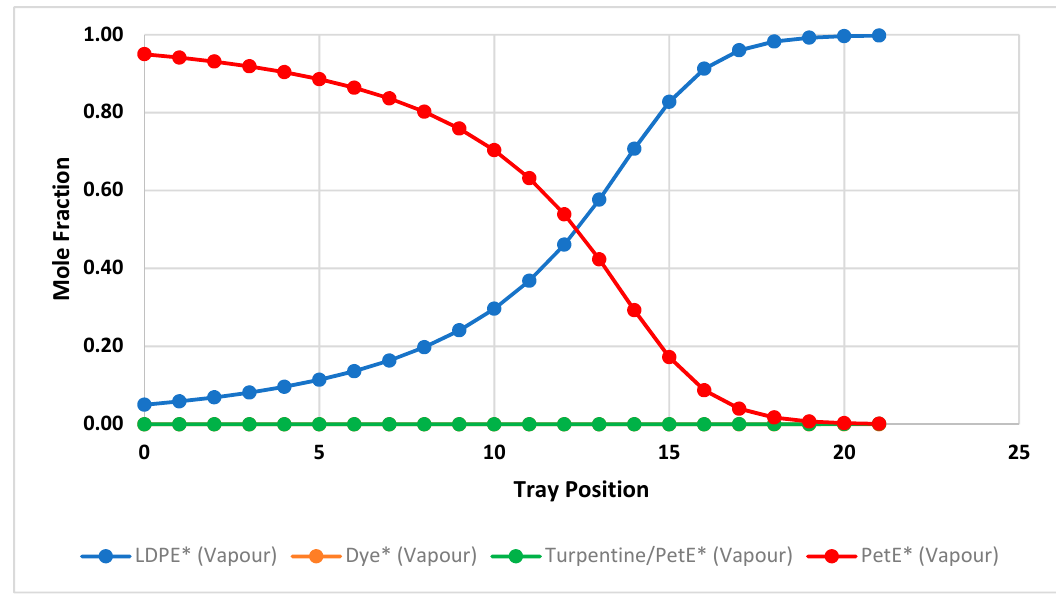
Figure 5. Composition against Tray position from the top of the reprecipitation column.